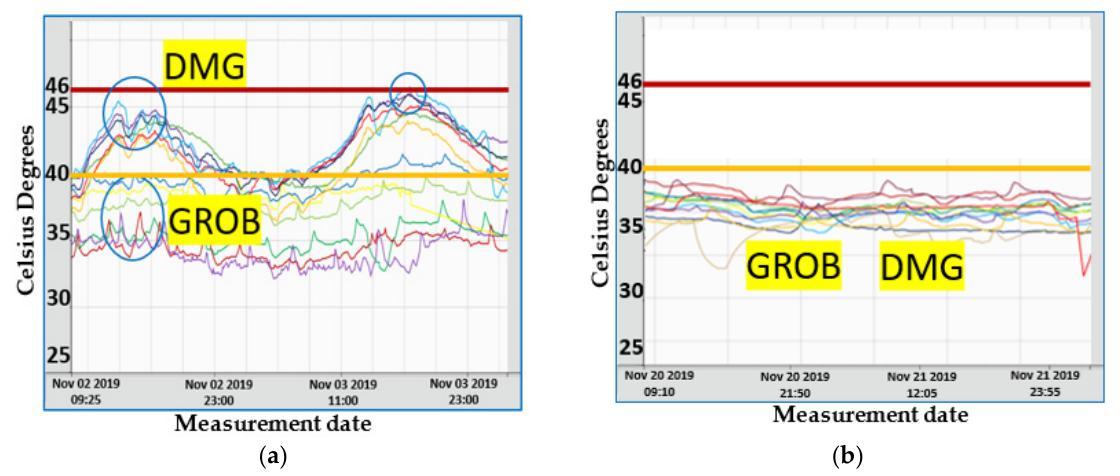
Figure 6. Machine state: ( a ) before maintenance; ( b ) after maintenance.